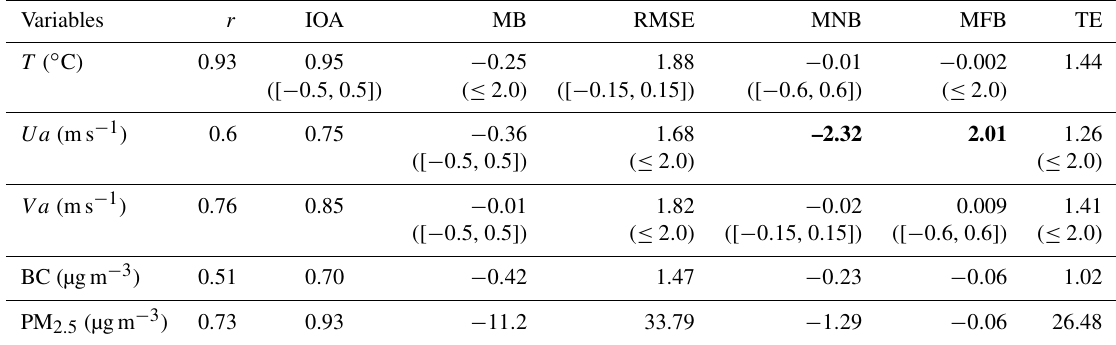
Table 3. Statistical indicators for evaluating the simulation results.